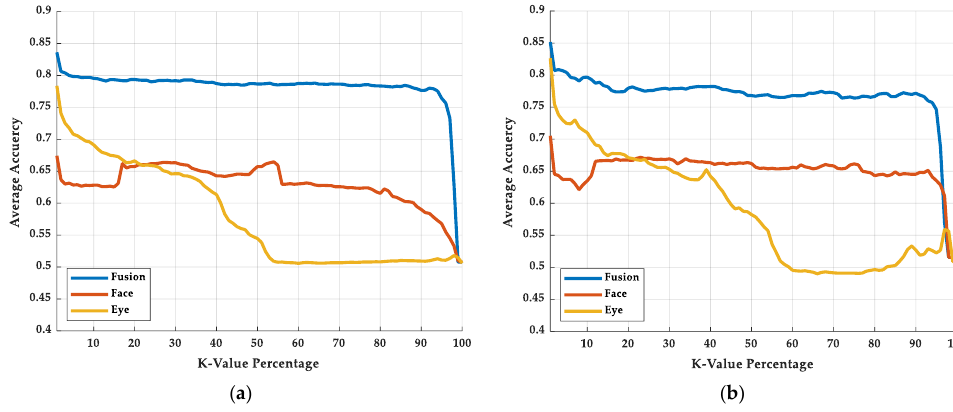
Figure 10. The KNN-Sigma results: ( a ) training results and ( b ) testing results.